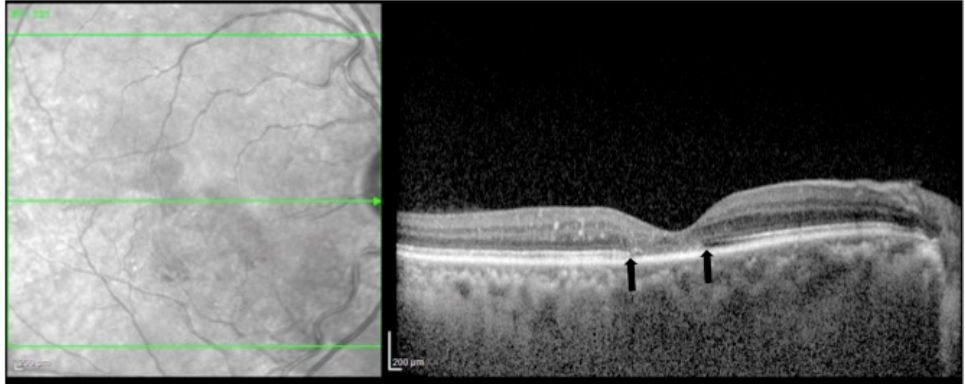
Figure 4: Horizontal spectral domain optical coherence tomography image through the fovea of the right eye one month after Ranibizumab therapy shows reduction of the central foveal thickness and complete resolution of the cystoid changes. Few hyperreflective dots corresponding to hard exudates are still seen and central loss of ellipsoid zone is seen centrally (between open